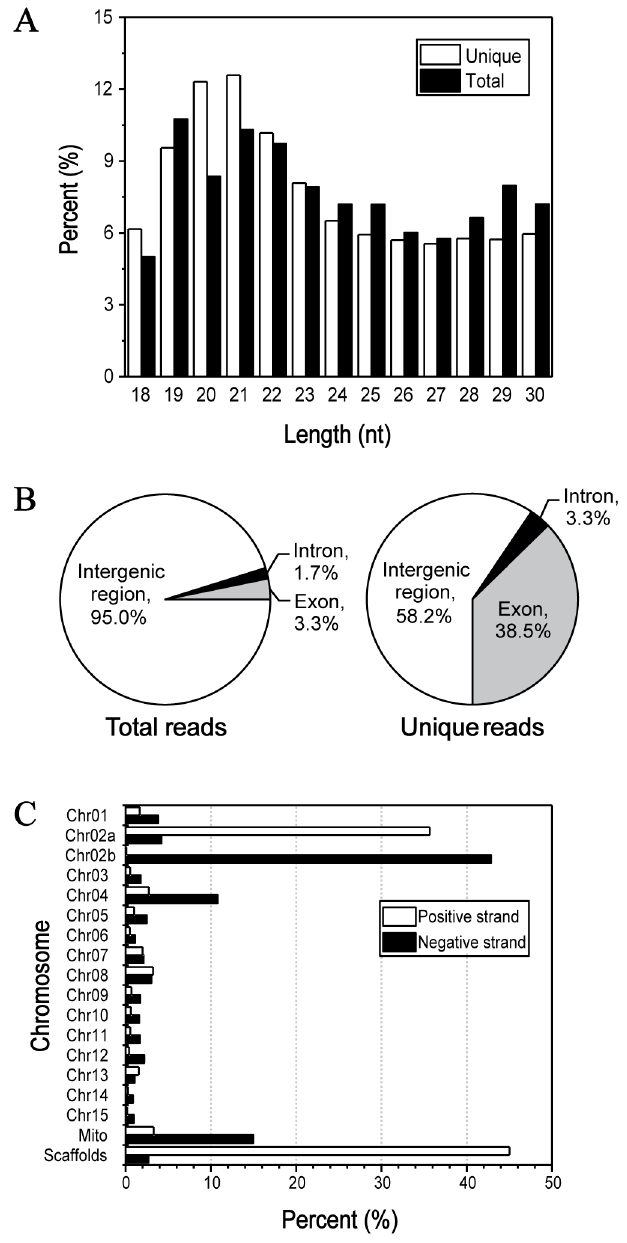
Figure 1. Characterization of small RNAs in F.oxysporum . A: Size distribution of small RNAs. White and black columns represent unique and total reads of the small RNAs, respectively. B: Annotation of small RNA loci. Pie graphs show the proportions of small RNAs located in intergenic, exonic and intronic regions, respectively. C: Small RNA distribution on both strands of chromosomes.